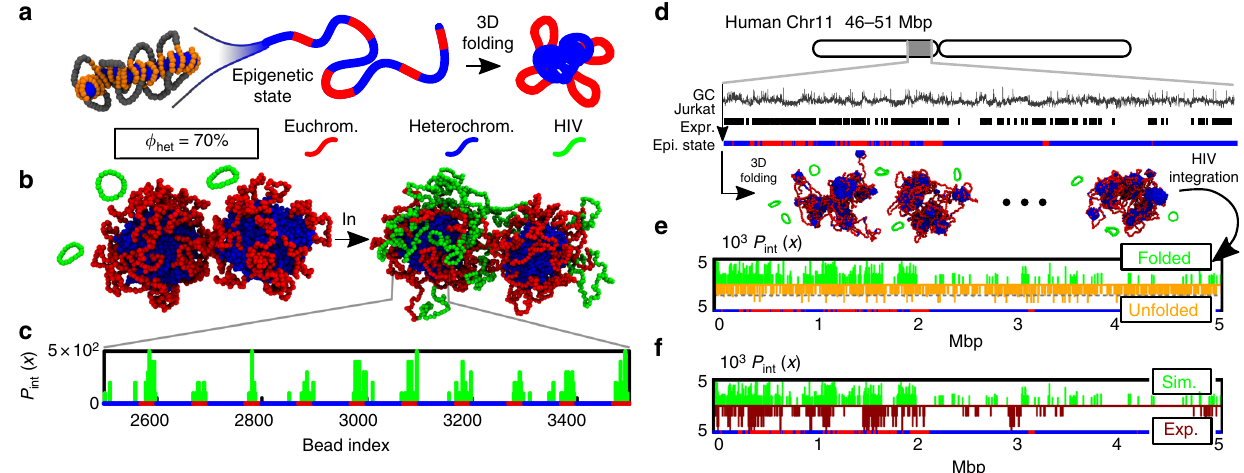
Fig. 3 Large-scale 3D chromatin folding enhances euchromatic integration. a Pictorial representation of our coarse-grained model which describes chromatin as a fi bre with epigenetic marks. These marks dictate 3D folding by self-association through proteins and transcription factors 22,49 . b Snapshots of our polymer model where the fraction of heterochromatin is set at ϕ het = 70%. We show two typical con fi gurations, before and after integration events. c The integration probability displays a strong enrichment in euchromatic regions. d – f Simulations of a 5 Mbp region of human chromosome 11 (46 – 51 Mbp) modelled at 1 kb resolution with a polymer N = 5000 beads long. d In this model, expression level in Jurkat T-cells and GC content are used to label beads as euchromatic (red) or heterochromatic (blue), respectively. We assign attractive interactions ( ϵ ¼ 3 k B T ) between heterochromatin beads so that the fi xed epigenetic pattern guides the folding of the chromatin fi bre (see snapshots). Steady-state conformations are then used as hosts for n = 500 integration events of a 10 kbp viral DNA. e Comparison between the distribution of integration sites in folded and unfolded chromatin conformations. The latter is obtained by assigning no self-attraction between heterochromatin beads. Viral integration within unfolded chromatin is uniform ( P int = 1/ n , dashed line) while it is not uniform (i.e. non-random) on folded chromatin. f Comparison between simulated and experimentally measured distribution of integration sites in Jurkat T-cells 16 . The agreement between simulations and experiments is highly signi fi cant, with a p -value p < 0.001 when a Spearman Rank is used to test the null-hypothesis that the distributions are independent. This result can be compared with the p -value p = 0.6 obtained when the same test is performed to test independence of the integration pro fi les in experiments and unfolded chromatin. The dynamics corresponding to one of our simulations is shown in full in Supplementary Movie 7. Source data are provided as a Source Data fi